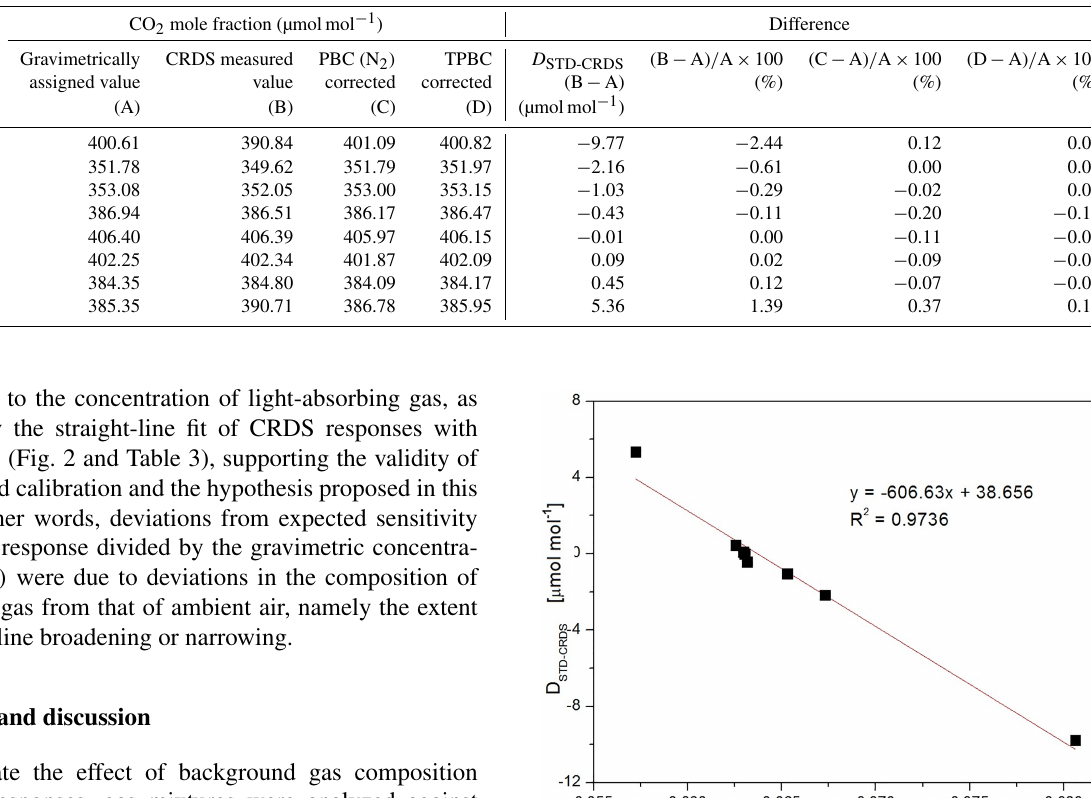
Table 4. CO 2 concentrations determined by gravimetry and measured by well-calibrated CRDS, together with the correction due to N 2 - induced pressure broadening (PBC(N 2 )) and total pressure broadening coefficient (TPBC). Differences between the measured (corrected) and assigned concentrations are also listed.